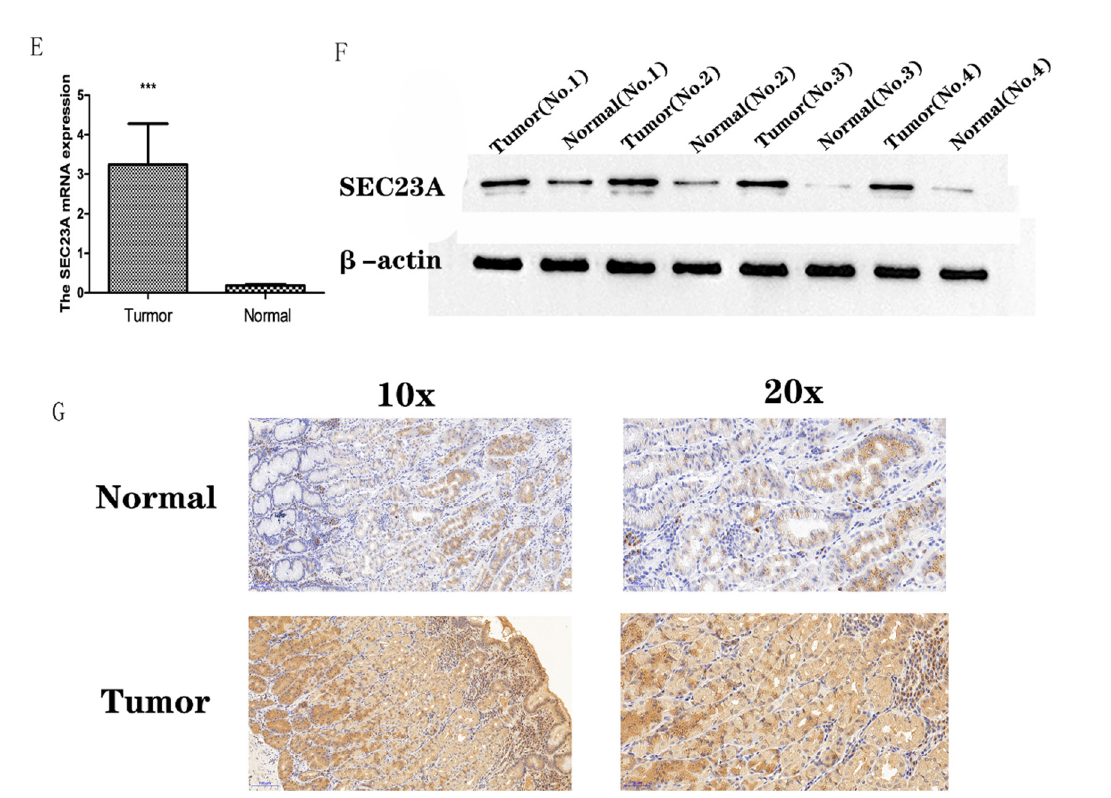
Figure 1. Expression of SEC23A in tumors (* p < 0.05, ** p < 0.01, *** p < 0.001, ns (not significant) p > 0.05). ( A ) Transcript levels of SEC23A in 33 cancer entities based on TCGA and GTEx. ( B ) Tran- script levels of SEC23A in STAD based on TCGA and GTEx. ( C ) Analysis of SEC23A expression in tumor and normal tissues based on GSE66229. ( D ) Analysis of SEC23A expression in tumor and normal tissues based on GSE118916. ( E ) qRT-PCR analysis of SEC23A expression in matching tumor and normal tissues from 16 STAD patients. ( F ) Expression of sec23a protein analyzed by WB in matching tumor and normal tissues from 16 STAD patients. ( G ) Expression of sec23a protein analyzed by immunohistochemistry in matching tumor and normal tissues from 16 STAD patients. The uncropped blots are shown in File